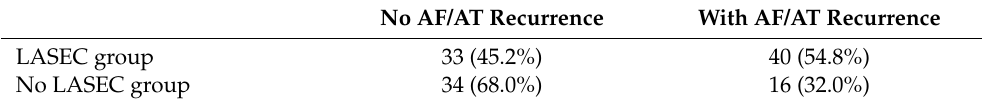
Table 3. Contingency table with incidence of AF/AT recurrence at 18 months.